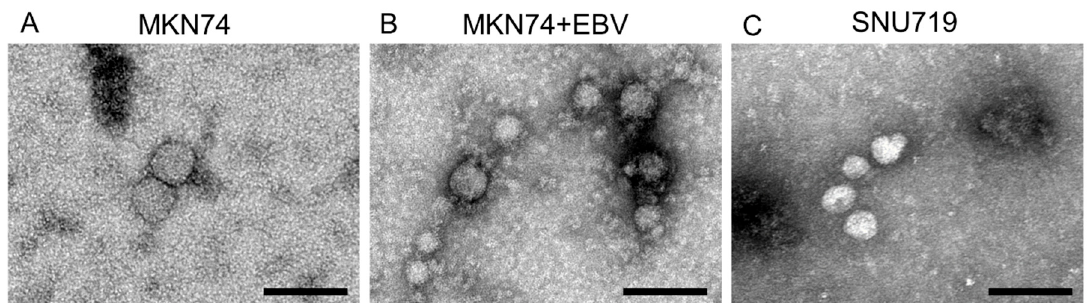
Figure 2. Characterization of exosomes by transmission electron microscopy ( A – C ). Exosomes were extracted from culture supernatant of gastric cancer cell lines by ultracentrifugation. Exosomes were recognized as small vesicles 30–100 nm in diameter under transmission electron microscopy. ( A ) MKN74, ( B ) MKN74 + EBV, ( C ) SNU719. Scale bar: 100 nm.